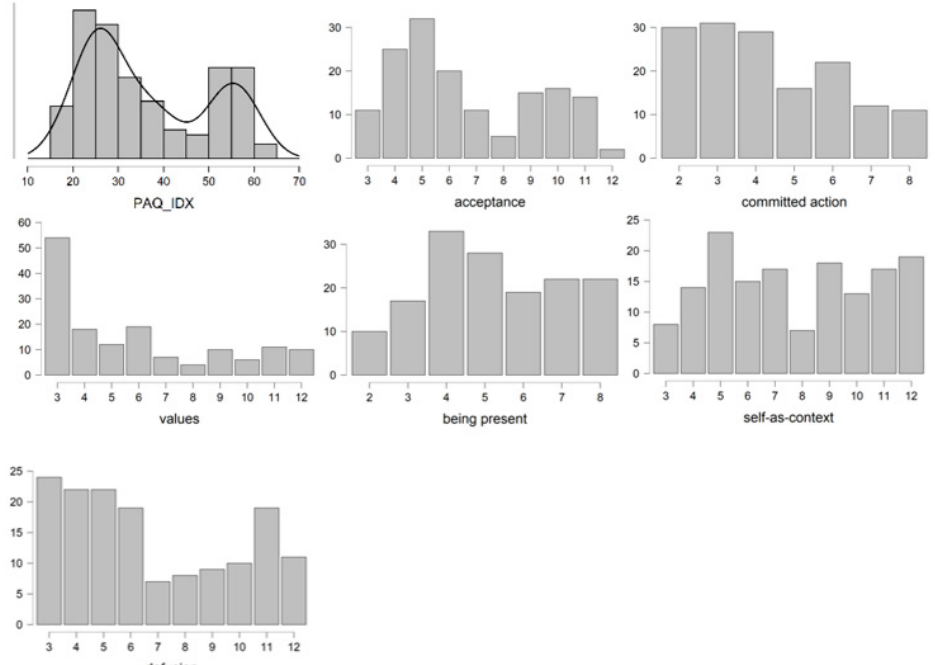
Figure 1. Distribution of the scores of 6-PAQ and its subscales. Note: PAQ_IDX: 6-PAQ total score.